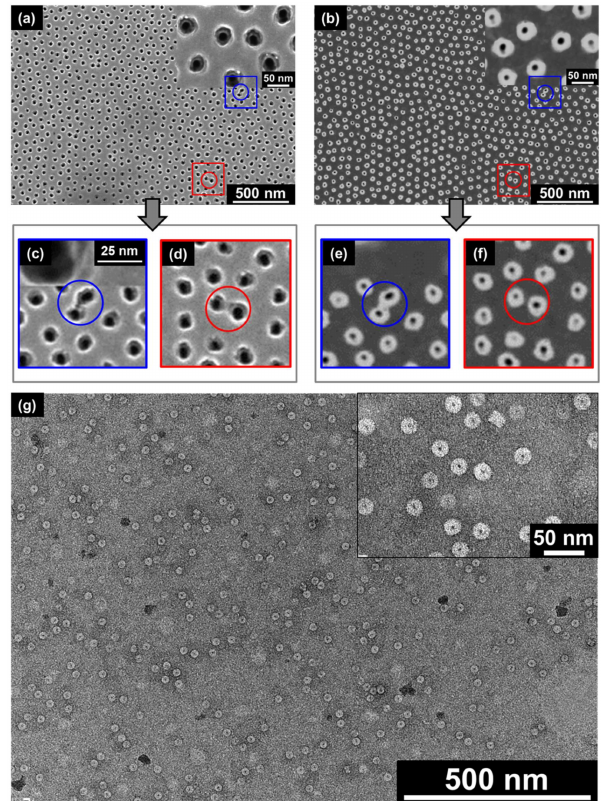
Figure 3. ( a ) Secondary electron top view SEM image of the SSM. ( b ) Dark field transmission mode SEM image of the backside of the SSM. ( c , d ) are the zoom-in images of the blue and red squares in image ( a ), respectively. ( e , f ) show the backside pore apertures corresponding to ( c , d ), respectively.